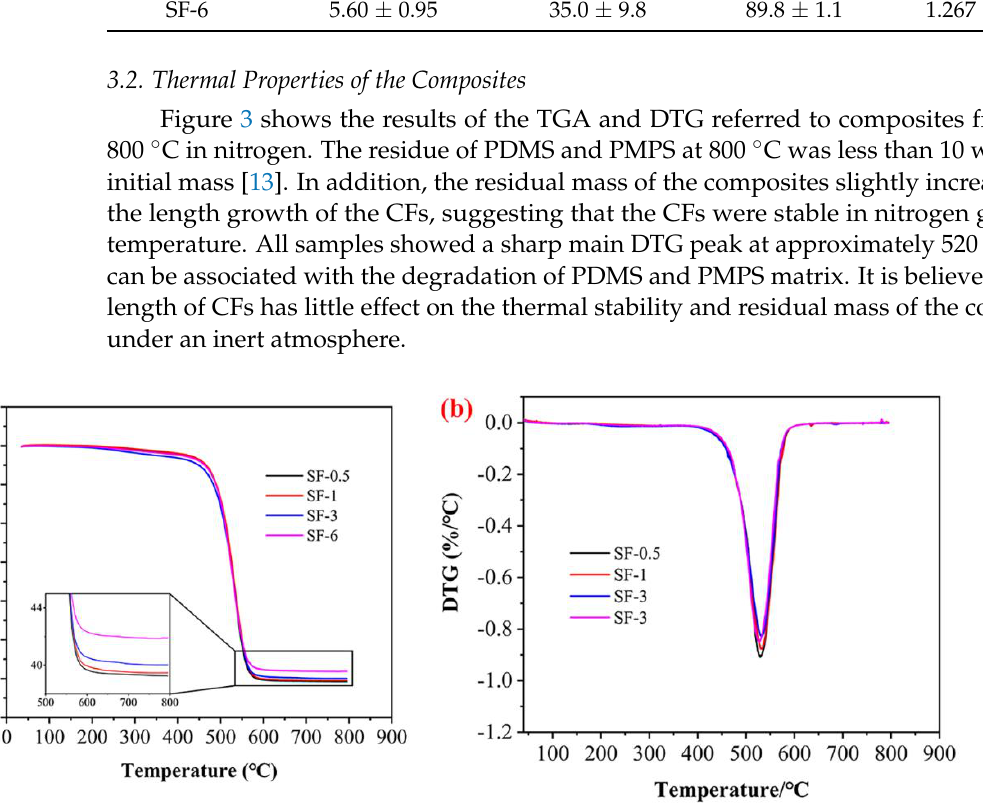
Figure 3. TGA ( a ) and DTG ( b ) patterns of composites under a nitrogen